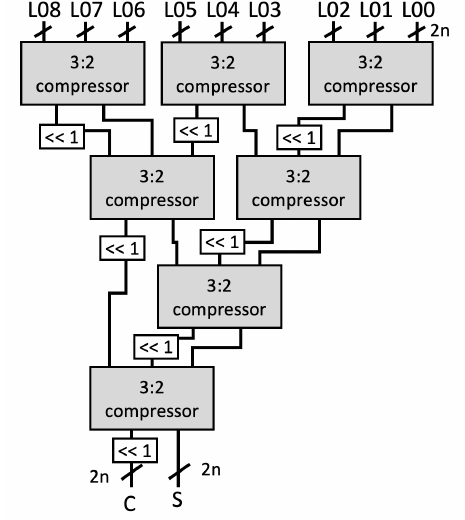
Figure 4. Example of Carry Save Adder Tree (CSAT) for nine